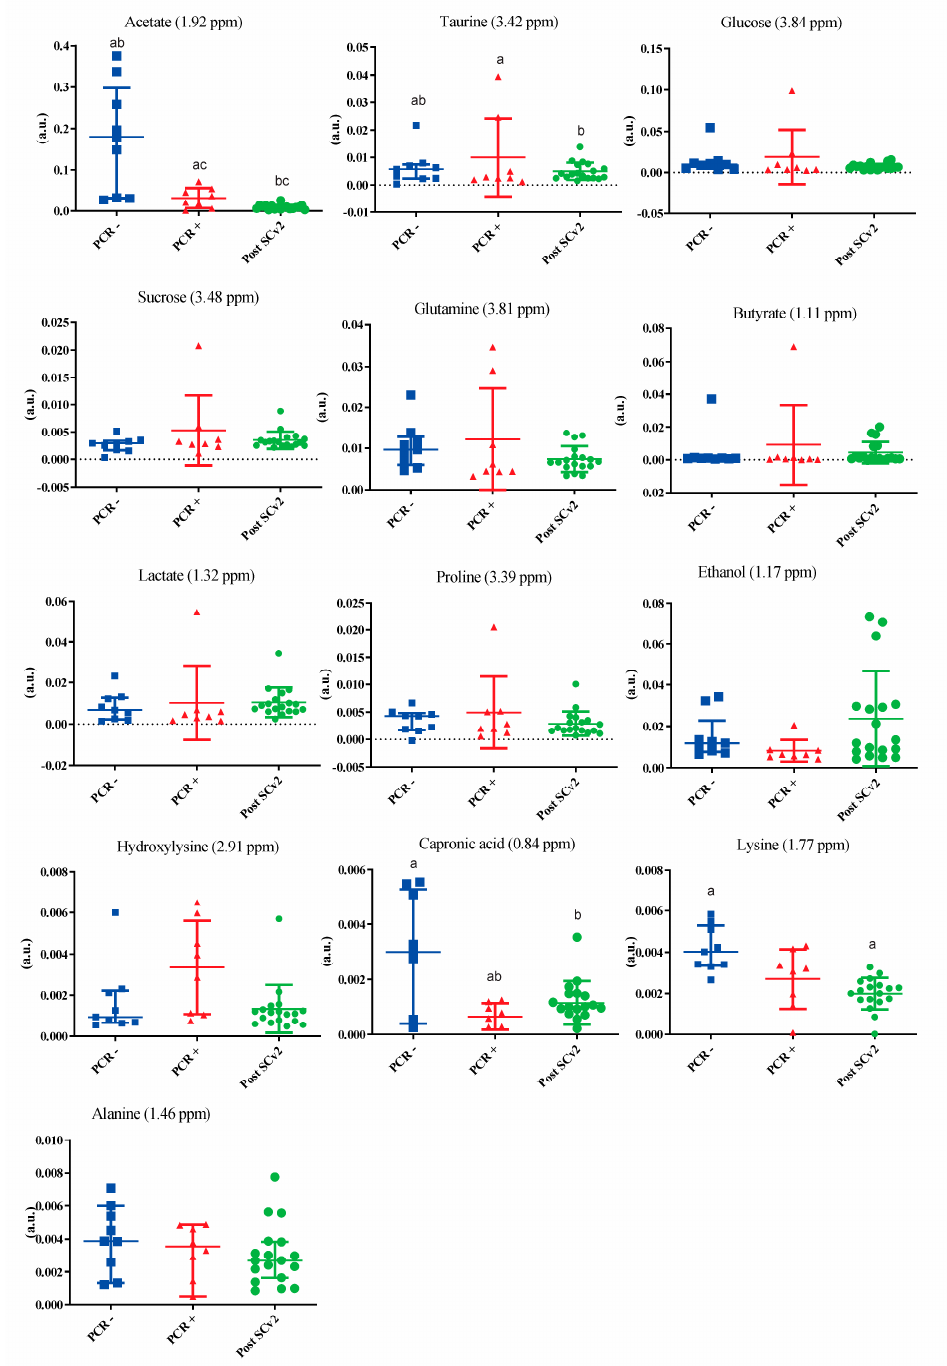
Figure 2. Metabolites highlighted by VIP score demonstrate the differences between PCR − , PCR+, and post-SARS-CoV-2 infection (post-SCv2). The metabolites that presented statistical differences in the univariate analysis (Supplementary Figure S1) are indicated using letters; the same letter indicates a statistical